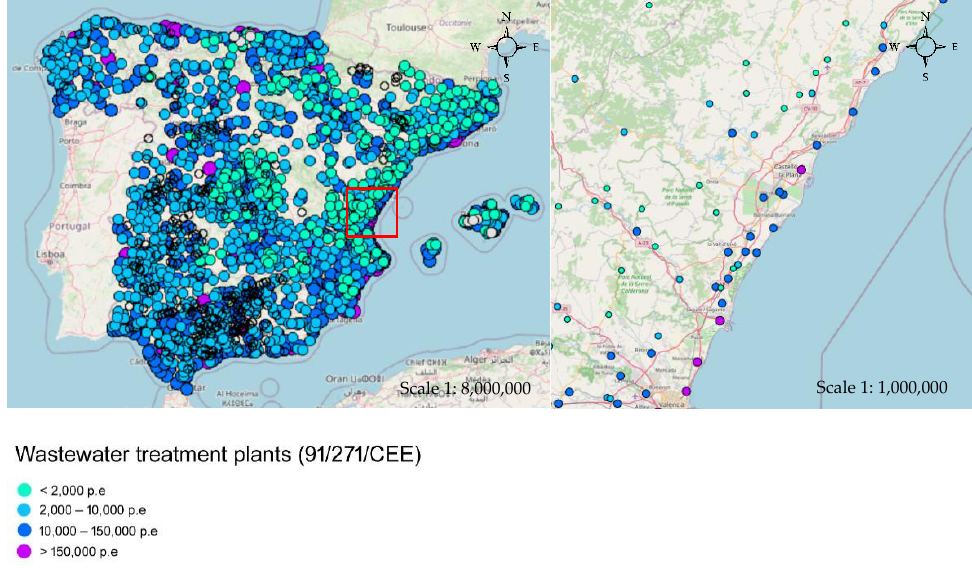
Figure 1. Wastewater treatment plants in Spain and Castellón de la Plana. Source: Ministry for Ecological Transition (2019). Table 2. Number of WWTPs by technology and province (Valencian Community). Prepared by the authors. Source: EPSAR, 2021.